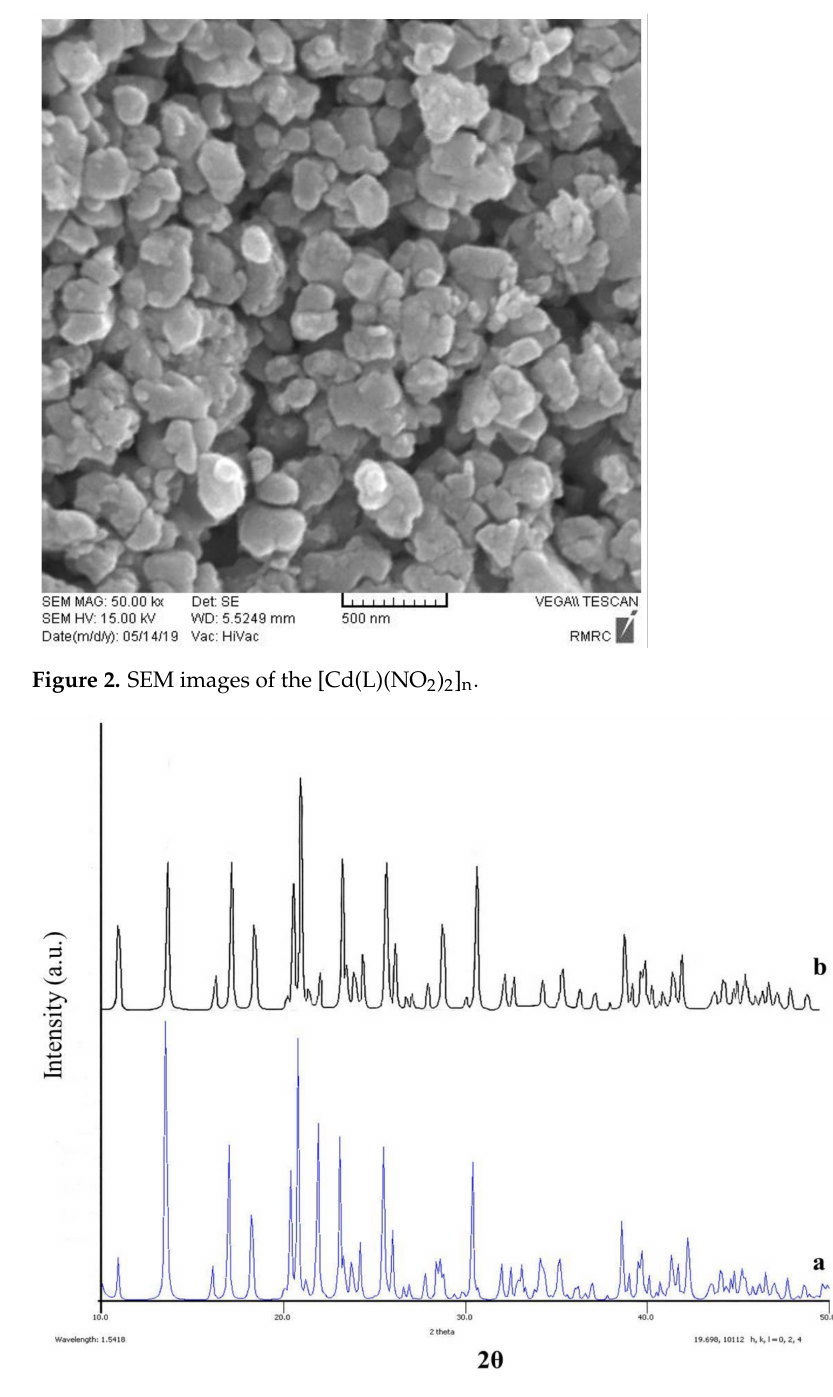
Figure 3. The PXRD patterns of compound [Cd(L)(NO 2 ) 2 ] n ( 1 ): ( a ) Simulated from single-crystal X- ray data and ( b ) nanostructure of ( 1 ) prepared by sonochemical method. Based on the crystal structure of 1, the composition and stereochemistry of a building block [Cd(L)(NO 2 ) 2 ] n ) were disclosed. A view of the molecular structure is shown in Figure